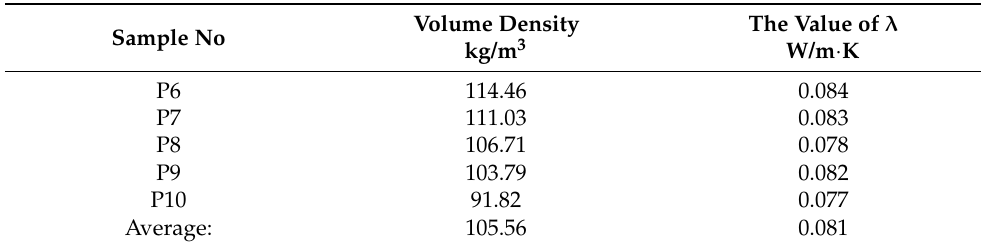
Table 3. Comparison of density and heat transfer ( λ ) values for straw test pieces with stalk orientation parallel to heat flow